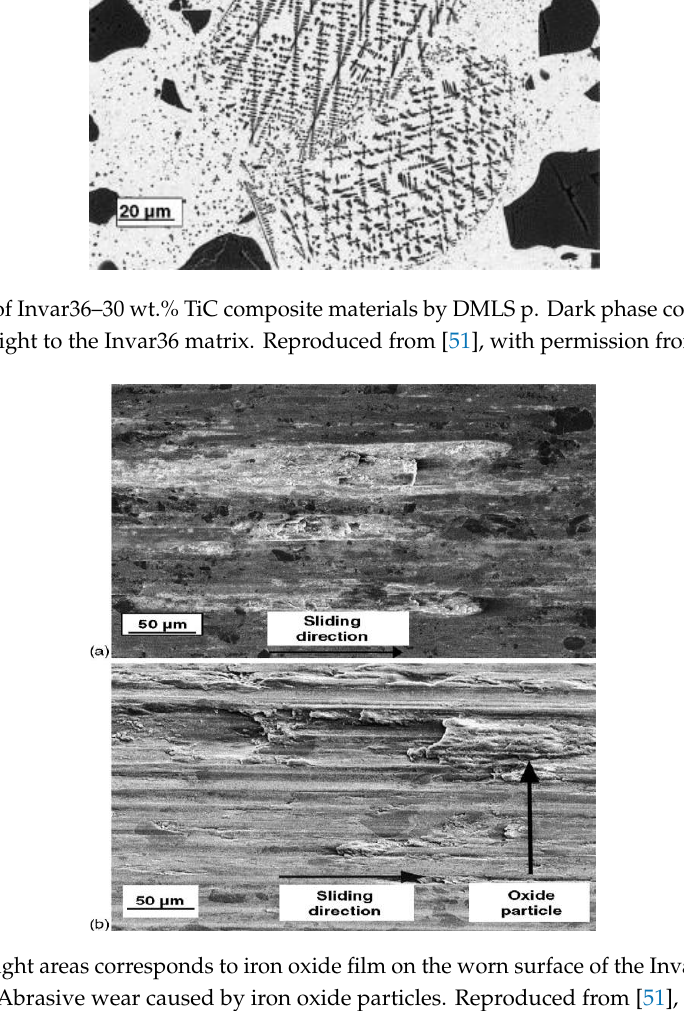
Figure 9. ( a and b ) SEM of iron and iron – SiC composites (sintered at laser speed of 100 mm/s). Reproduced from [53], with permission from Elsevier, 2009. Figure 10. Wear rate of iron and iron-SiC composites. Reproduced from [53], with permission from Elsevier, 2009.